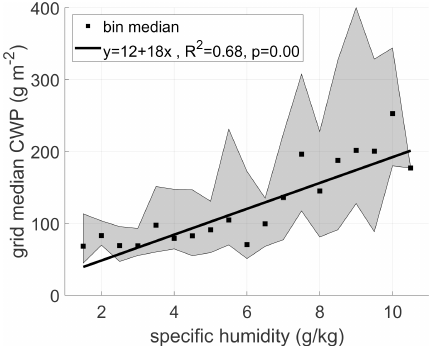
Figure 10. Cloud water path as a function of specific humid- ity. The squares correspond to the median of observations in each 0.5gkg − 1 wide specific-humidity bin, and the range between 25th and 75th percentiles is shaded. Individual satellite observations were the median of CWP pixels in a 1 ◦ × 0 . 5 ◦ view over Hyytiälä, when the number of cloudy pixels was at least 20% of the max- imum (i.e. same criterion as for the considered COT observations in Fig. 8). A least-squares regression weighed with the number of observations in each bin is fitted to the bin medians. The regression equation, adjusted R 2 , and p value are shown in the